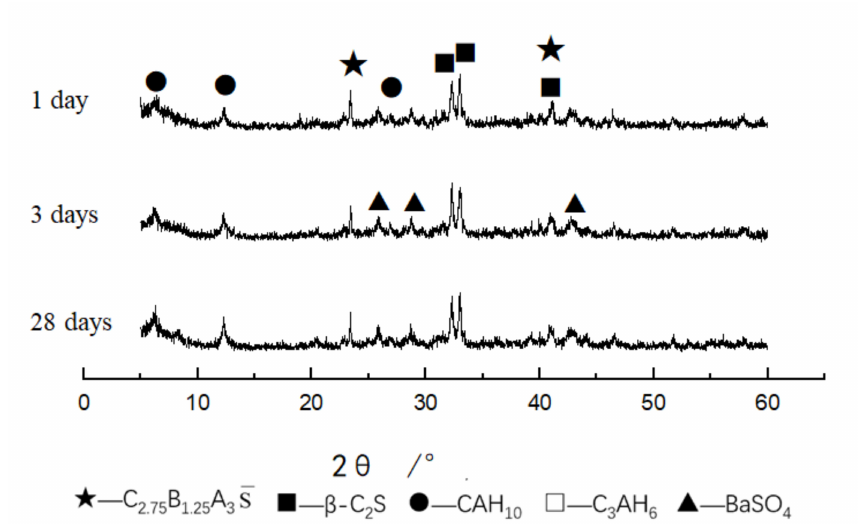
Figure 16. XRD patterns of sample CF3 at different hydrated days.